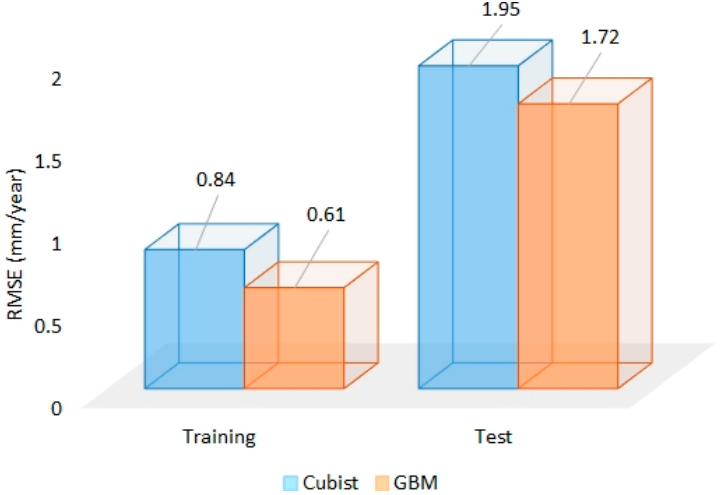
Figure 5. Comparison of the average RMSE (mm/year) values between Cubist and